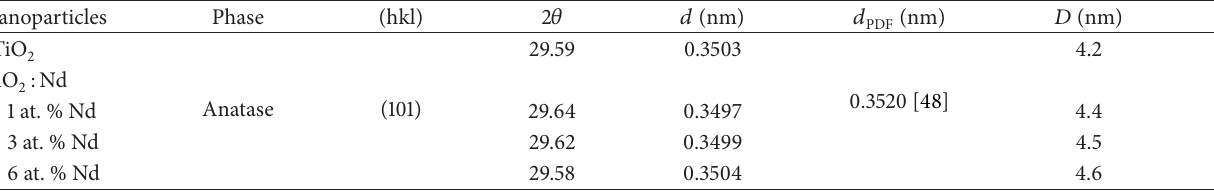
Table 1: Influence of Nd-dopant on structural parameters of titanium dioxide nanoparticles, based on XRD results.